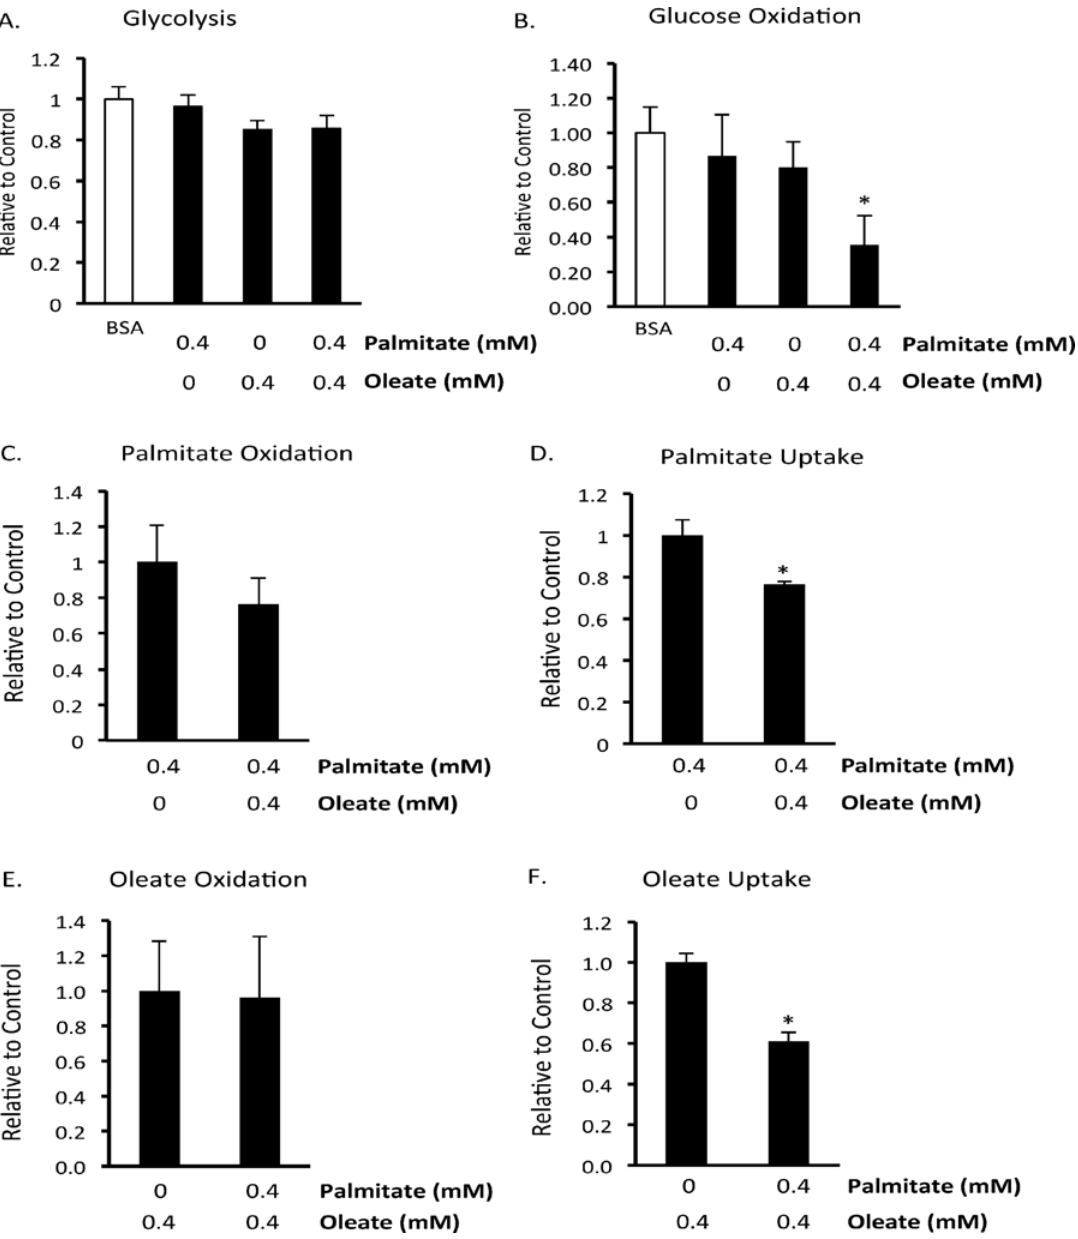
Fig 4. Effect of acute exposure to fatty acids on human BMMSC energy metabolism. A) Glycolysis, B) glucose oxidation, C) palmitate oxidation, D) palmitate uptake, E) oleate oxidation, and F) oleate uptake were measured in untreated human bone marrow mesenchymal stem cells (BMMSCs). n = 5 – 7 During each assay Krebs Henseleit buffer was supplemented with 5 mM glucose and, as indicated in each graph, either 0.55 mM albumin (BSA group) or 0.55 mM albumin bound to 0.4 mM palmitate and/or 0.4 mM oleate. In addition, the Krebs Henseleit buffer was supplemented with either [U- 14 C]glucose, [1 – 14 C]palmitate, [1 – 14 C]oleate, or [5 – 3 H]glucose for the measurement of glucose oxidation, palmitate oxidation and uptake, oleate oxidation and uptake, or glycolysis, respectively. Since these experiments assessed the acute effect of palmitate and oleate, BMMSCs were maintained in cell culture media used to culture these immediately up to the start of each assay when the media was switched to Krebs Henseleit buffer supplemented with fatty acids. The levels and type of fatty acid BMMSCs were exposed to is indicated on the x-axis of the figures. * Significantly different from all groups. Values are shown as the mean ±